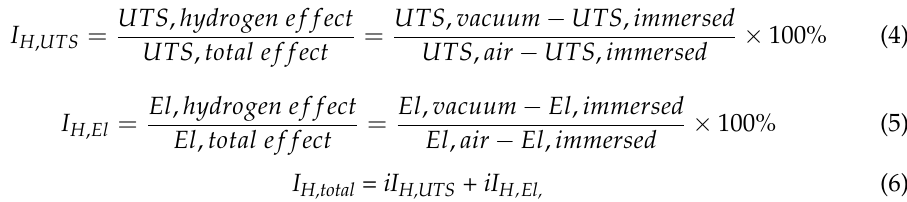
Figure 5. ( a ) UTS, ( b ) El, and ( c ) calculated I SCC data of the as-cast and solid-solution-treated AM50 magnesium alloy